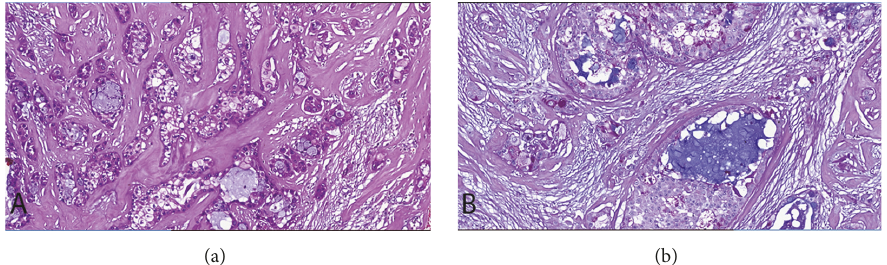
Figure 2: Hematoxylin and eosin stain (original magnification × 20) (a) and periodic acid schiff/alcian blue stain (original magnification × 20) (b) of the tumour specimen showing the pathologic features of a low-grade mucoepidermoid carcinoma of the lacrimal